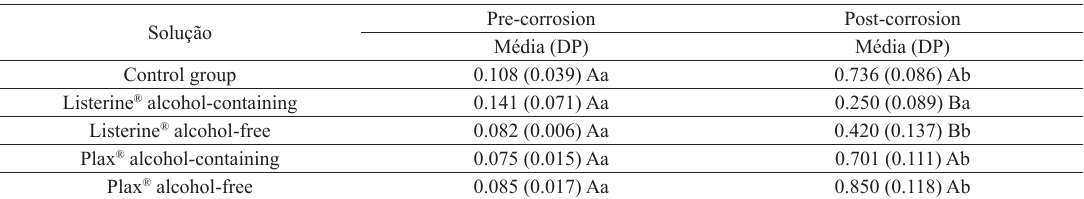
Table 3. Surface roughness mean and significance interval (95%) of CoCr alloy tested in different mouthwashes. pre and post-corrosion areas.